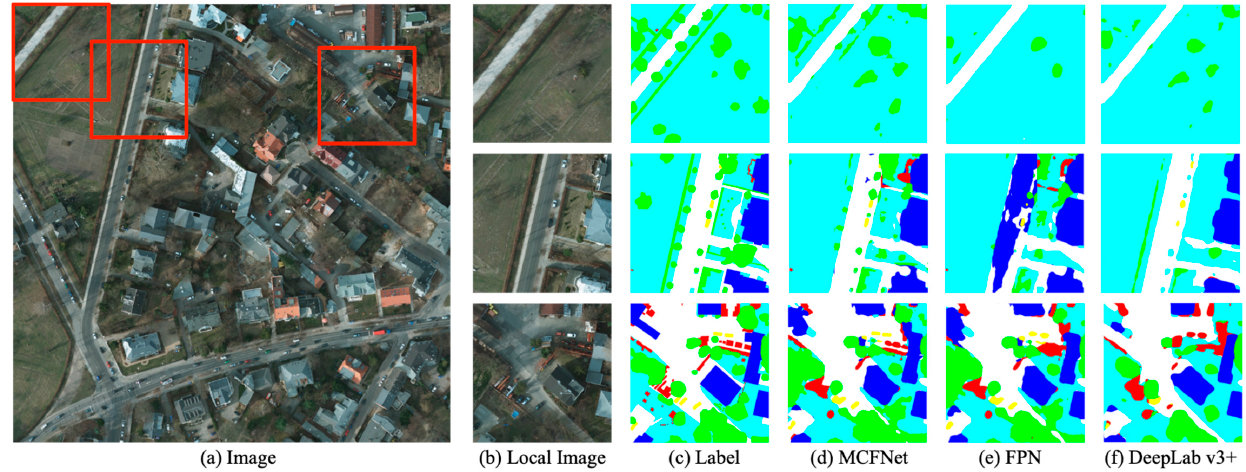
Figure 10. Local details of the Postdam image through different methods.